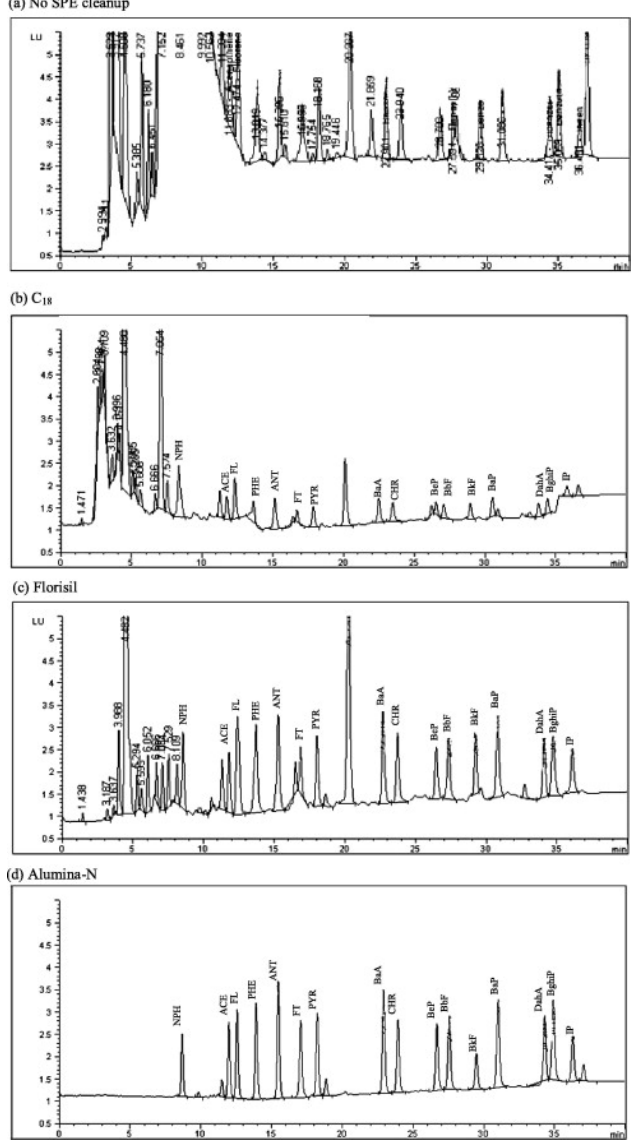
Figure 2. Chromatograms of HPLC-FLD analysis of PAHs after low temperature clean-up followed by ( a ) no SPE clean-up, ( b ) C18, ( c ) Florisil, and ( d ) alumina cartridges [73].